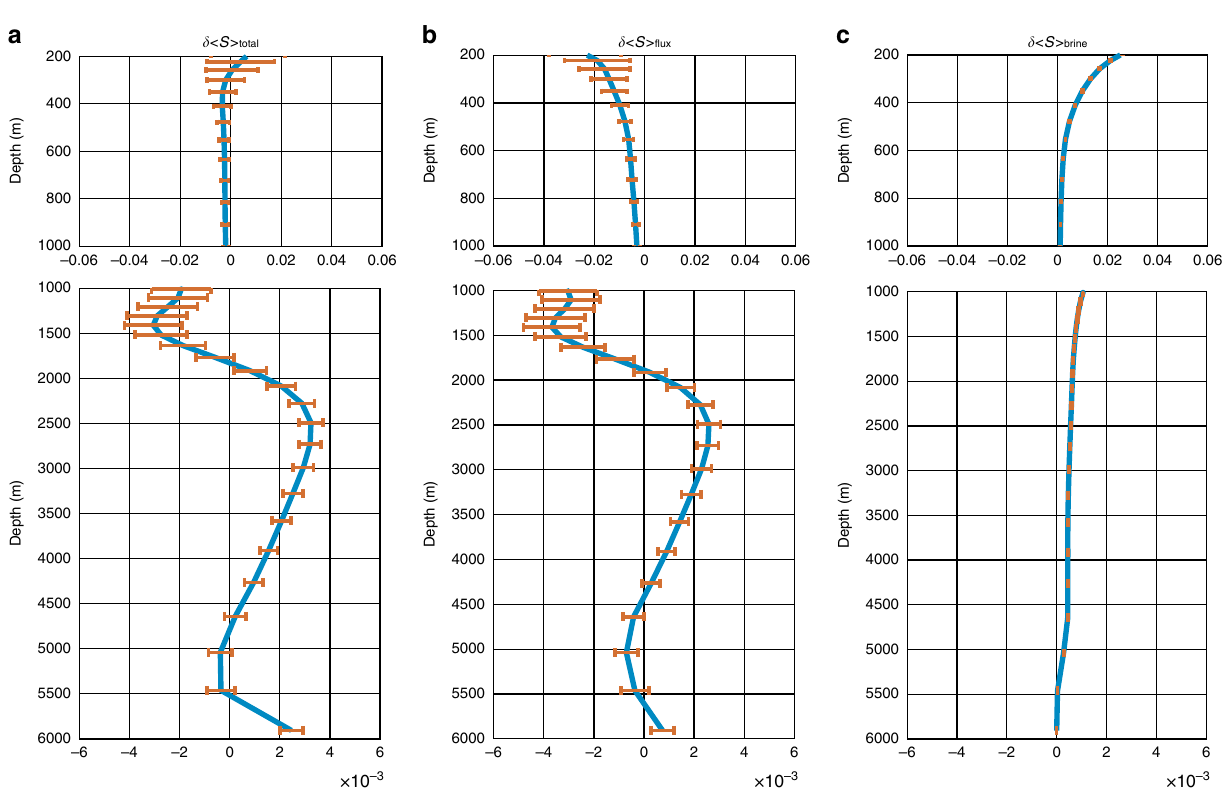
Fig. 2 22-year changes of the globally averaged ocean salinity. a Changes of the horizontally averaged ocean salinity ( δ <S> total , unit: psu) calculated as December 2014 minus January 1993 values. b Salinity changes due to the net vertical salt fl ux ( δ <S> fl ux , unit: psu). c Salinity changes due to the brine rejection ( δ <S> brine , unit: psu). The upper 200 m are excluded to avoid direct impacts from the intense high-frequency variability. The error bars are ffiffiffi p n calculated as σ = , where σ is the temporal standard deviation of the corresponding term, and n is the degrees of freedom (261 in this